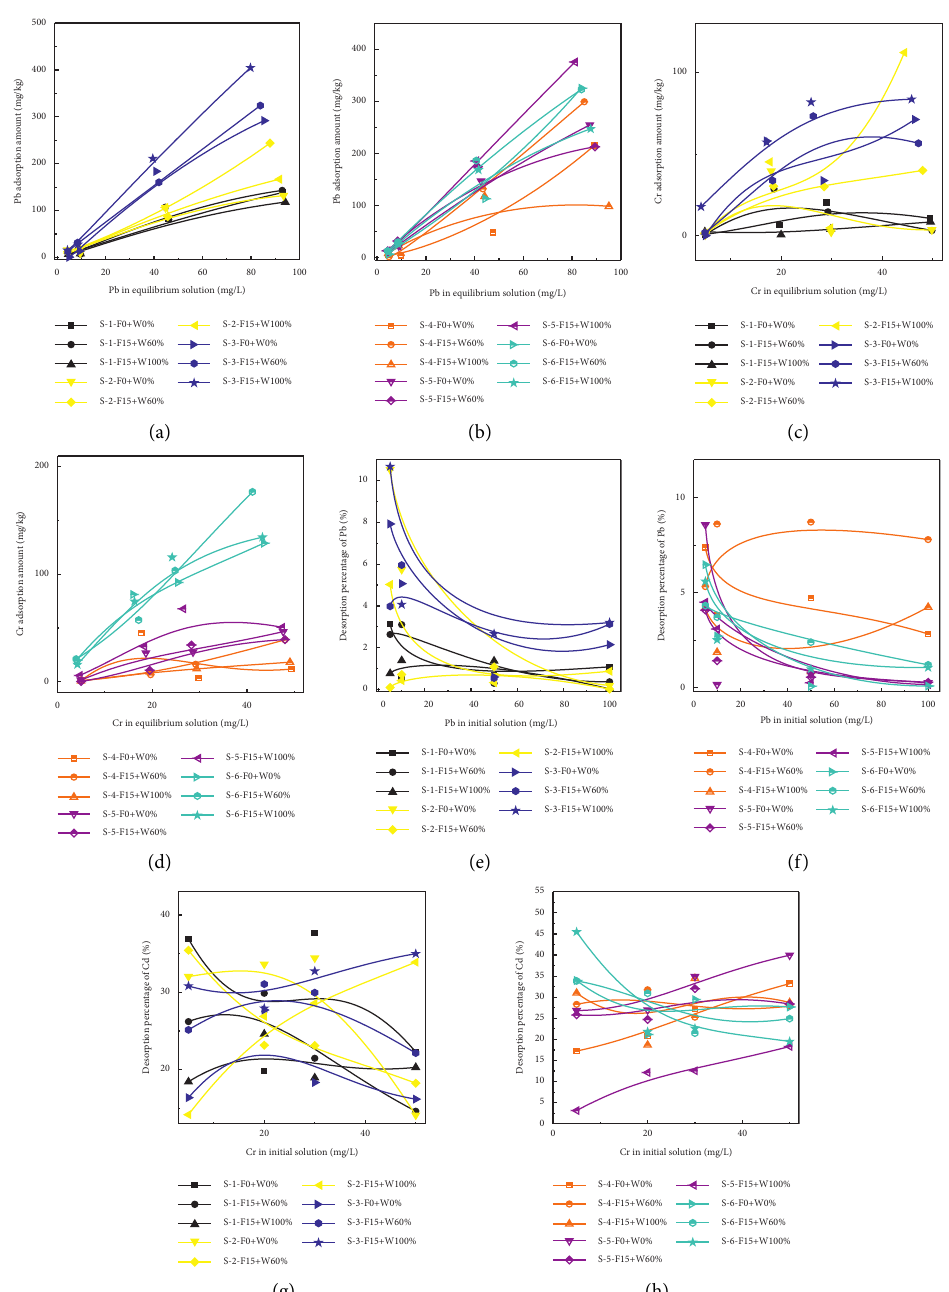
Figure 2: Adsorption amounts and desorption rates for Pb and Cr by soils under different freeze-thaw conditions. F0 and F15 refer to the number of freeze-thaw cycles (0 and 15 cycles), and W0%, W60%, and W100% refer to water ratio of field capacity (0%, 60%, and 100% water